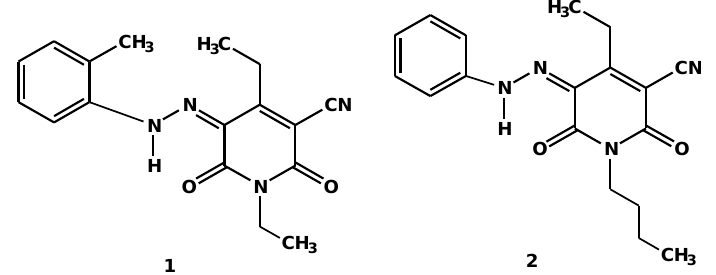
Figure 1. Structures of disperse dyes 1 and 2.